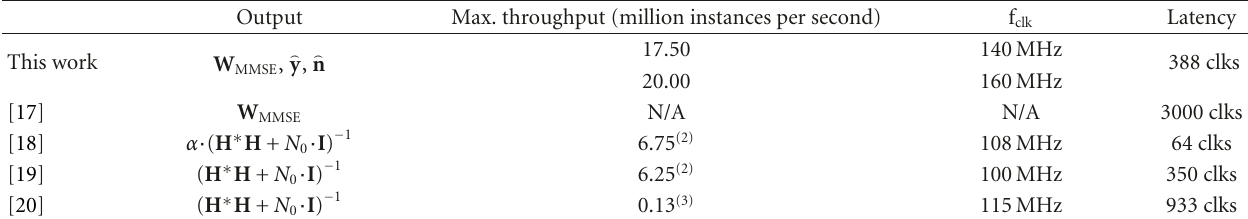
Table 8: Throughput and latency comparison.